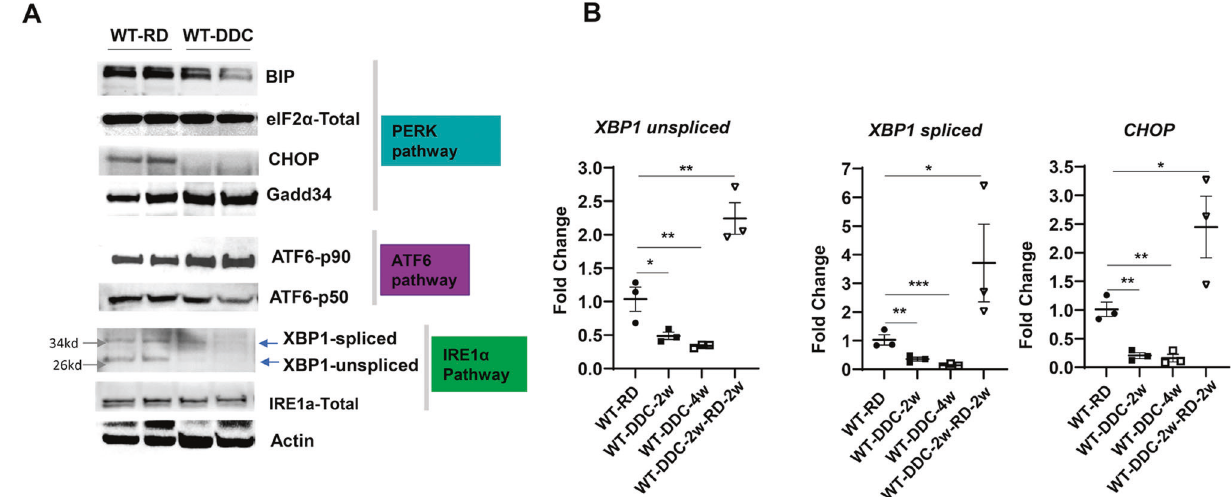
Fig. 4 Inhibition of autophagic fl ux by DDC diet is not triggered by ER stress. A Total liver lysates were analyzed by immunoblotting for PERK Pathway (BIP, eIF2a, CHOP, GADD34, ACTIN), ATF6 pathway (ATF-p90, ATF-p50, ACTIN), and (IRE1a pathway (XBP1-spliced, XBP1- unspliced, ACTIN) proteins. B Quantitative PCR analysis for XBP1-uncut, XBP1 spliced, and CHOP mRNA expression from wild type mice fed with regular diet (RD), 2 – 4 weeks of DDC diet, and 2 week DDC followed by RD. The mRNA expression levels were normalized to actin. Data are expressed as the mean±SEM. * P ≥ 0.05, ** P ≥ 0.01, *** P ≥ 0.001 ( n =